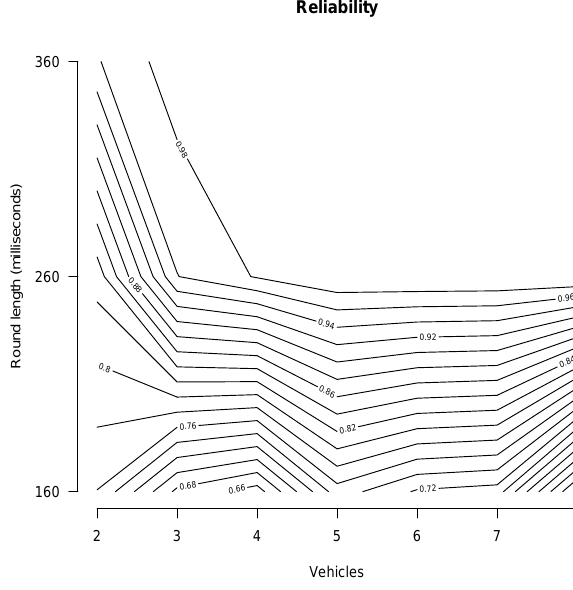
Figure 3. The percentage of time that all vehicles agree on the cooperative operation mode (number of vehicles vs. the round length in